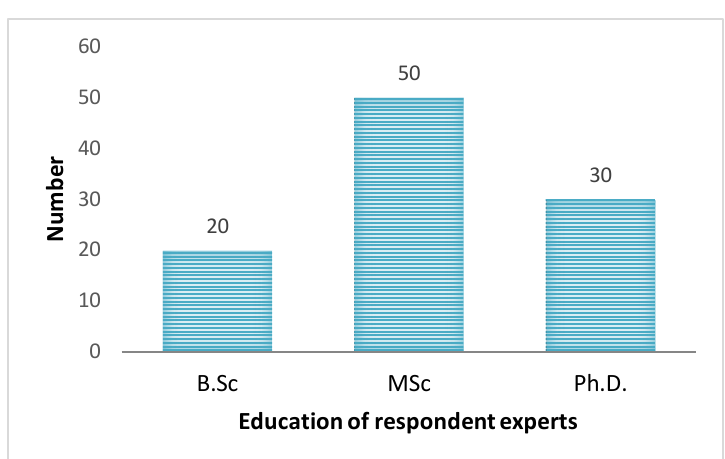
Fig. 2. Age of respondent experts.